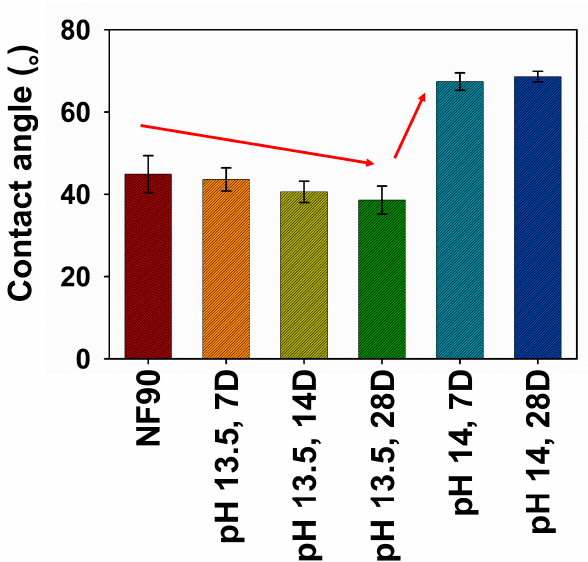
Figure 3. Contact angles of pristine NF 90 and post-treated membranes ( n = 10).